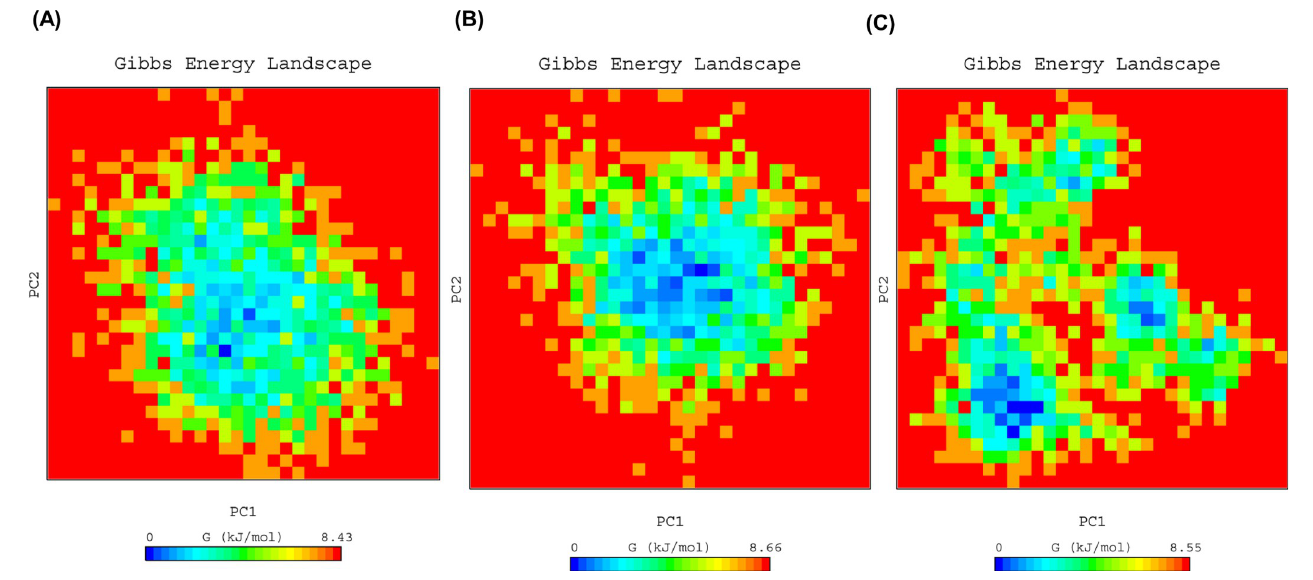
Fig 5. PC1 and PC2 Gibbs free energy landscape for (A) BtEcR, (B) BtEcR-ZINC08952607, and (C) BtEcR-ZINC04264850.